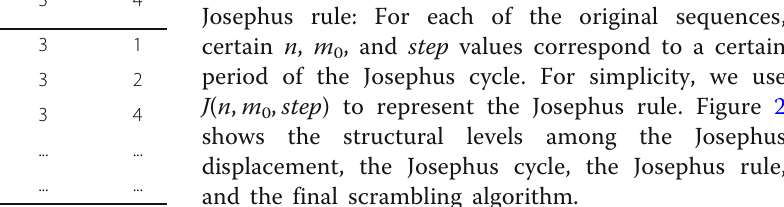
Table 1 Josephus cycle states in experiment 1 New sequence generated by j times the